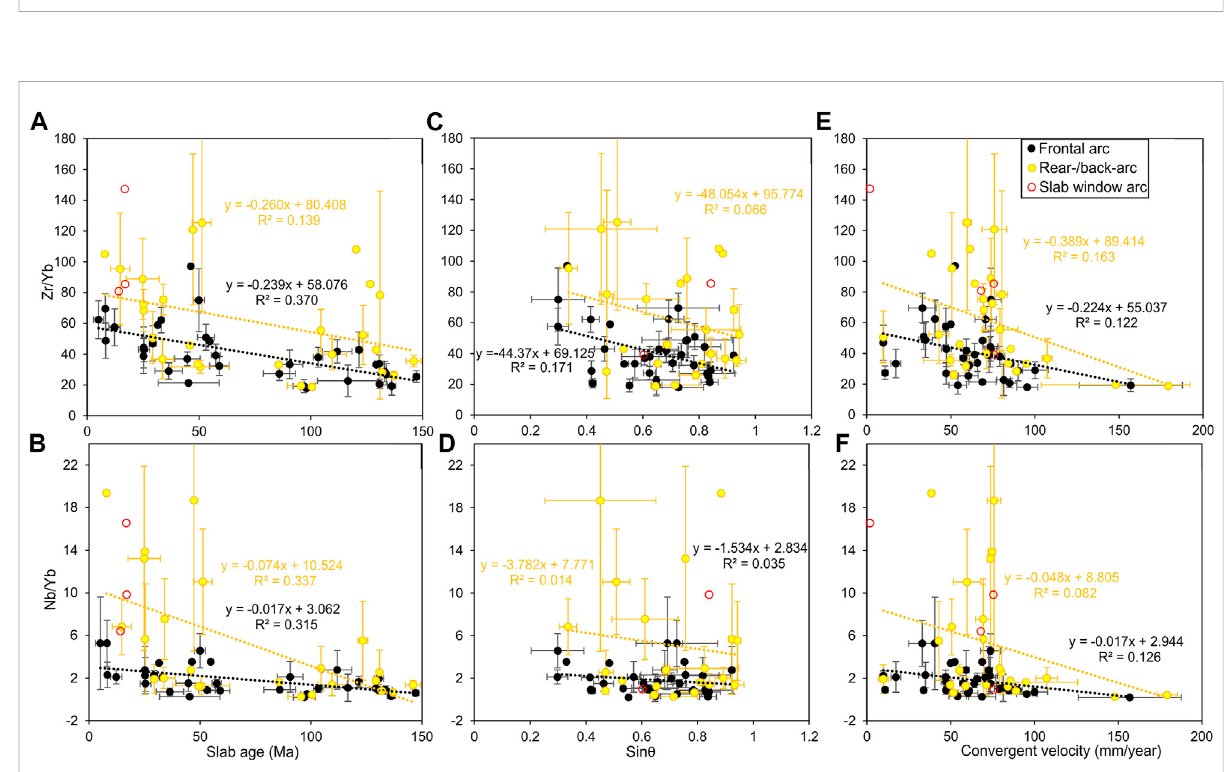
FIGURE 5 Slab parameters vs.ratios oftraceelements whichare immobile inaqueous fl uids. Slabage vsZr/Yb (A) andNb/Yb (B) . Sin θ vsZr/Yb (C) andNb/ Yb (D) . Convergent velocity vs Zr/Yb (E) and Nb/Yb (F)